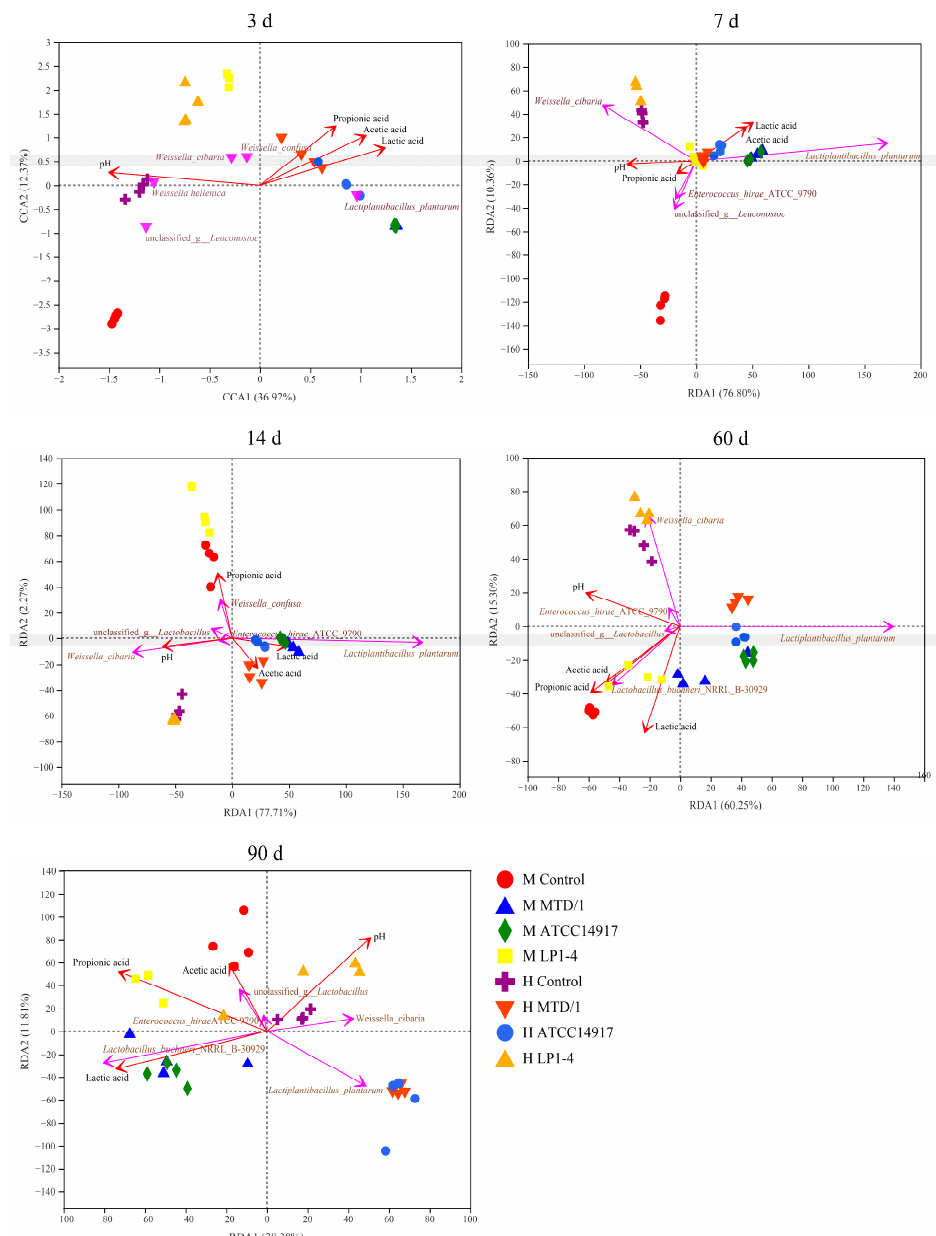
Figure 4. RDA dynamics of relationships among fermentation characteristics, treatments, and species in alfalfa silage. Top 5 species in total abundance in a taxonomic level were selected at the moderate and high dry matter contents, respectively. The length of the arrow represents the degree of influence on treatments. The angle between the arrows represents positive and negative correlation (acute angle: positive correlation; obtuse angle: negative correlation; right angle: no correlation). The distance between the projection point and the origin represents the influence of the fermentation characteristics on the distribution of the treatments and species. The default CCA is displayed when axis length is larger than or equal to 3.5; the default RDA is displayed when the axis length is smaller than 3.5 M, moderate dry matter content; H, high dry matter content. Control, distilled water; MTD/1, MTD/1 treatment; ATCC14917, ATCC14917 treatment; and LP1 ‐ 4, LP1 ‐ 4 treatment.